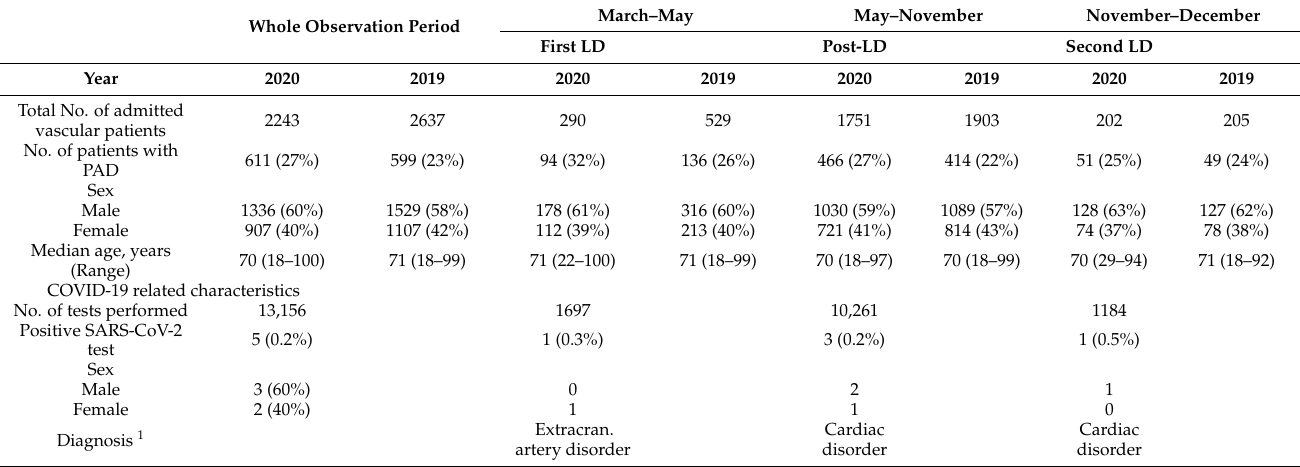
Table 1. Clinical and SARS-CoV-2 related characteristics of patients with vascular disorders.